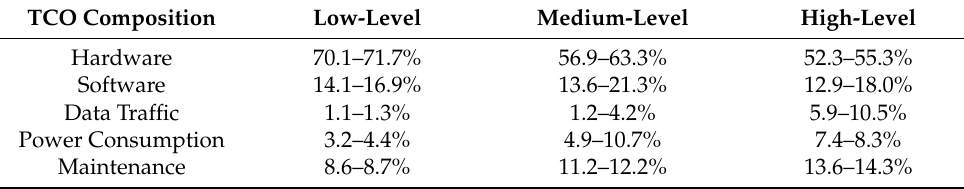
Table 5. TCO composition share at different levels of intelligent driving.